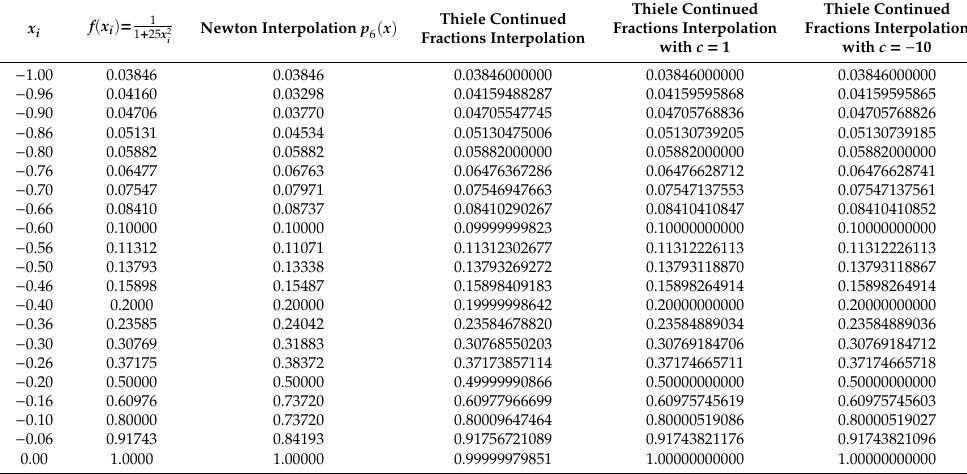
Table 2. Comparison table of di ff erent